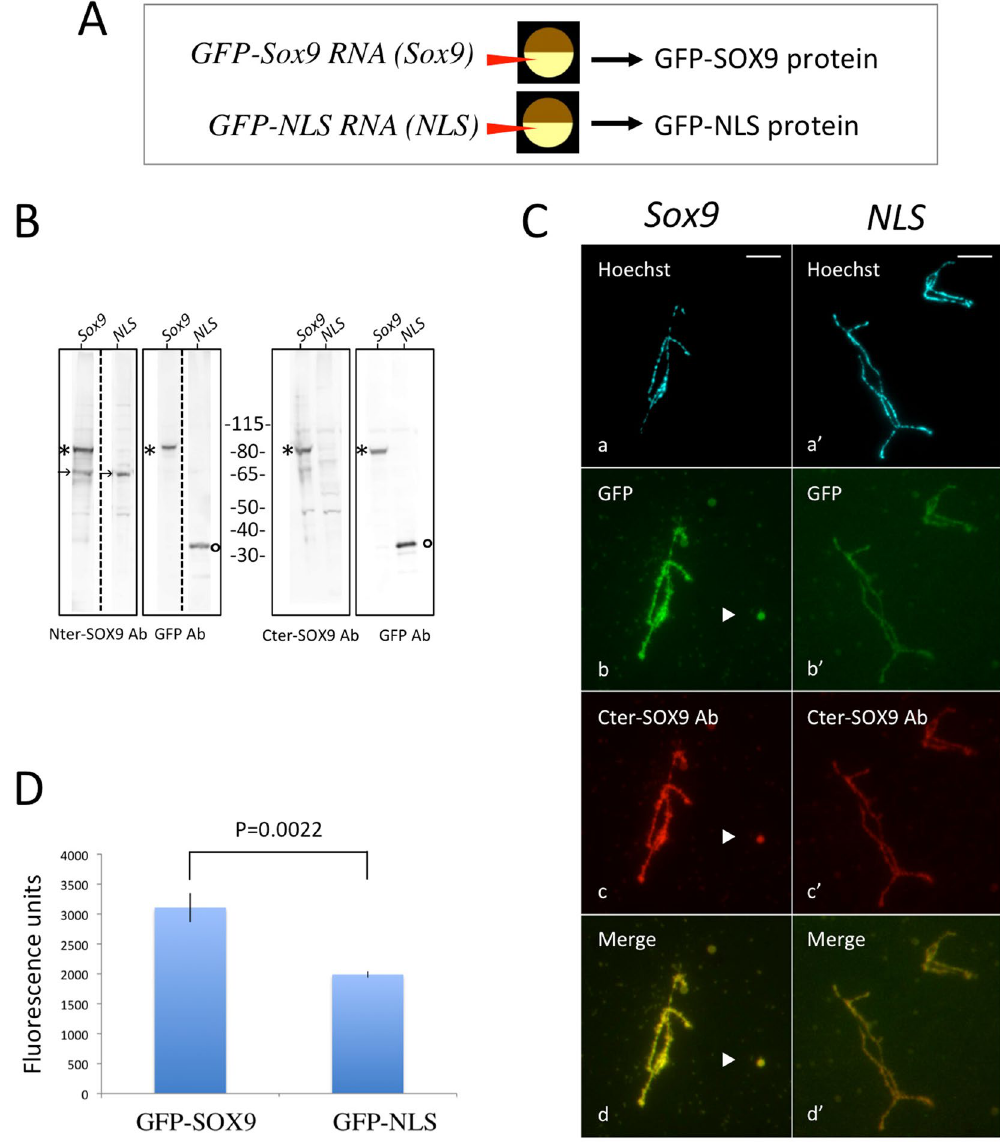
Figure 3. Targeting of the newly-synthetized Xt-SOX9-GFP protein to LBCs and nuclear bodies. ( A ) Capped, in vitro -synthetized transcripts from the pcDNA Xt-sox9- CT-GFP (Sox9) vector, or the control pcDNA NLS- CT-GFP (NLS) vector, were injected into the cytoplasm of stage IV-V oocytes of X. laevis . The expressed proteins (Xt-SOX9-GFP or NLS-GFP) were detected 18 hours later, either directly on nuclear spreads by fluorescence microscopy or indirectly on immunoblots using antibodies against the SOX9 or GFP proteins. ( B ) Immunoblots of nuclear extracts from injected oocytes with the sox9-CT-GFP ( Sox9 ) or NLS-CT-GFP ( NLS ) transcripts. Each lane corresponds to 15 GVs. kDa: molecular weight markers. A polypeptide ( * ) around 80 kDa detected with the anti-Nter or Cter- SOX9 antibodies and the anti-GFP antibody in the Sox9-CT-GFP injected oocytes corresponded to Sox9-GFP protein. In the NLS-CT-GFP injected oocytes, the anti-GFP antibody detected a 30 kDa polypeptide (°) corresponding the NLS-GFP protein. The polypeptide of ca. 68 kDa (arrows) corresponds to the endogenous SOX9 protein. The dashed lines separate the lanes which were cut from the original immunoblots shown in the supplementary figure S5. ( C ) (b, b’) Direct detection of GFP- SOX9 and GFP-NLS proteins on nuclear spreads from the injected oocytes. The GFP-SOX9 protein targeted the LBCs and the free nuclear bodies (arrowhead). A much lower level of GFP-NLS was detected on the LBCs. (c, c’) immunostaining of the nuclear spreads using the anti-Cter-SOX9 antibody. (d, d’) merged images (b, b’ and c, c’) indicating that the staining pattern of the Xt-SOX9-GFP was similar to that using the anti-Cter- SOX9 antibody. Wide field Leica microscope. Scale bar for all micrographs: 10 μ m. ( D ) Quantification of GFP fluorescence density on LBCs with the Otsu’s method. GFP-fluorescence density over the GFP-SOX9 LBCs was significantly higher than that of the control GFP-NLS LBCs (Student’s test, p =